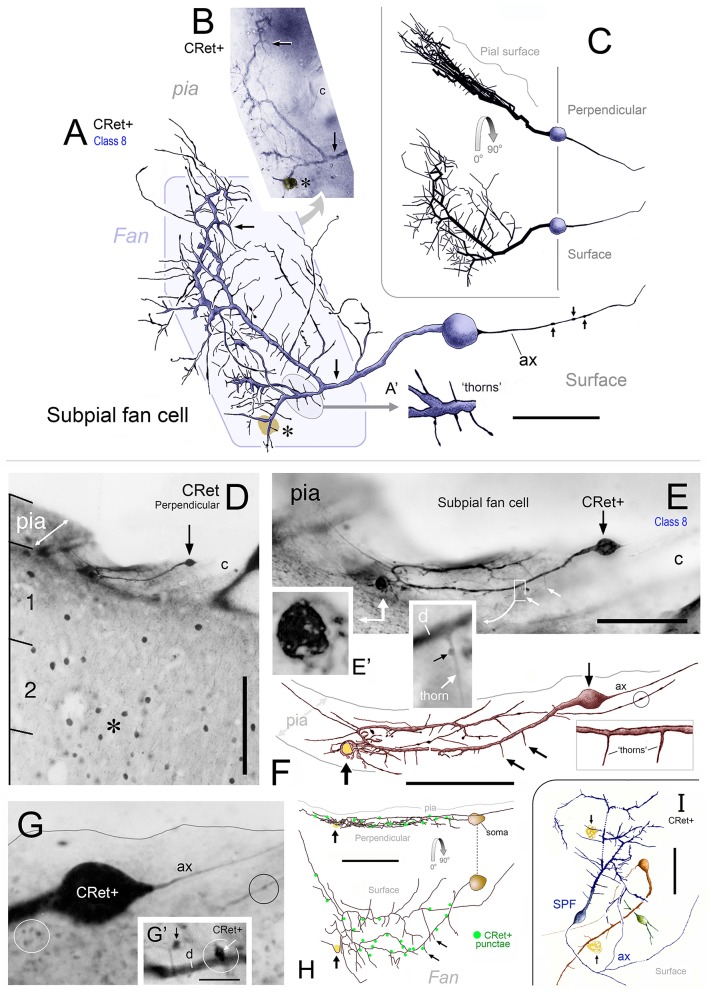
(A) Class 8. Area 46d. Reconstruction of a CRet+ SPF cell. Note the radiate fan-like distribution of the dendritic processes. Numerous thorn-like protrusions emanate from the main processes. Swellings along the axonal process (ax) are indicated. Scale bar: 50 μm. Inset (A′): Enlarged image of the region in (A) illustrating several long, fine thorn-like protrusions arising from a thick secondary dendrite. (B) Photomicrographic montage of the dendritic arbor indicated by the polygonal region in (A). (C) 3D rotations showing the distribution of the cellular processes viewed in the plane perpendicular to the pial surface (90°) and viewed parallel with the pial surface (0°). (D) Class 8. Area 24b. CRet immunolabeling in superficial layers 1–2. A CRet+ SPF cell is indicated (arrow). Note the paucity of other CRet+ neurons in layer 1 compared with the increased density of labeled neuronal somata in layer 2 (asterisk). The slanted white double headed arrow indicates the plane of the pial surface which lies oblique to the axis of viewing. Capillary, c. Scale bar: 200 μm. (E) Enlarged image of the SPF cell in (H). One pole of the ellipsoid soma (arrow) gives rise to a thick branching dendrite that recurves and courses tangentially directly beneath the pial surface. Thorn-like processes arising proximally from the main dendrite are indicated (small white arrows). Region outlined is enlarged in inset which shows a CRet+ puncta abutting a dendritic thorn (d, dendrite). A dark vacuolated cellular profile is shown enlarged in (E′) Capillary, c. Scale bar: 100 μm. Inset shows (F) Reconstruction of the neuron in (E) (arrow). Fine thorn-like processes (small arrows) emanate from the thick main process (see inset). A small-caliber terminal process gives rise to several varicosities (one of which is encircled). Scale bar: 100 μm (G) Photomicrograph of the SPF soma — note lack of filaments arising from soma (c.f. Figures 2C,F). A thin axon-like processes (ax) emerges from one pole of the soma. Swelling along an immunopositive process (black circle). CRet+ punctae (presumed synaptic boutons) are present in the neighboring neuropil (white circle). Scale bar: 25 μm. (G′) A CRet+ axonal swelling (white arrow) closely opposed to a CRet+ distal dendritic process (d). Another CRet+ puncta is indicated (black arrow). (H) 3D-rotations of the SPF cell to show the distribution of the immunolabeled cellular processes when viewed in the perpendicular plane and in surface view. Note the fan-like spread of the labeled processes. Indicated are the visible CRet+ punctae (green dots) abutting the processes of the SPF cell. Scale bar: 100 μm. (I) Surface view of a group of three neighboring CRet+ neurons in upper layer 1 of area 46d. Categorized as a class 8 SPF cell, a superficial class 7 cell and the profile of a partly immunolabeled neuron. Clumps of lipofuscin (arrows) (Axon, ax). Scale bar: 100 μm.